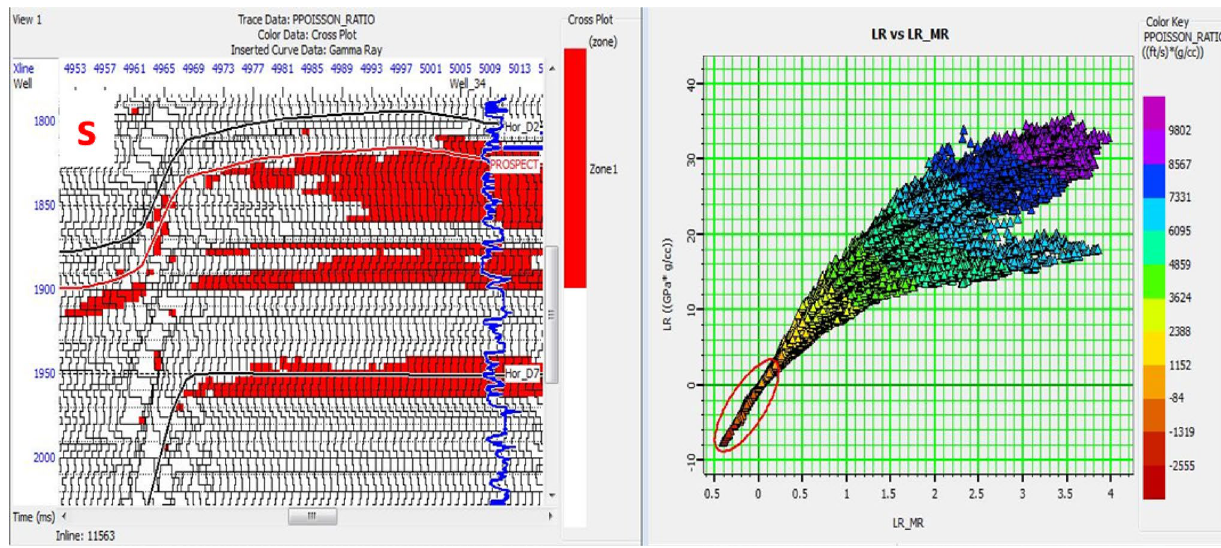
Fig. 11 Plot of Lambda-Rho versus Lambda-Rho/Mu-Rho ratio, color coded with Poisson ratio for Inline 11,563 confirming D2 reservoir to be hydrocarbon bearing in the prospective zone